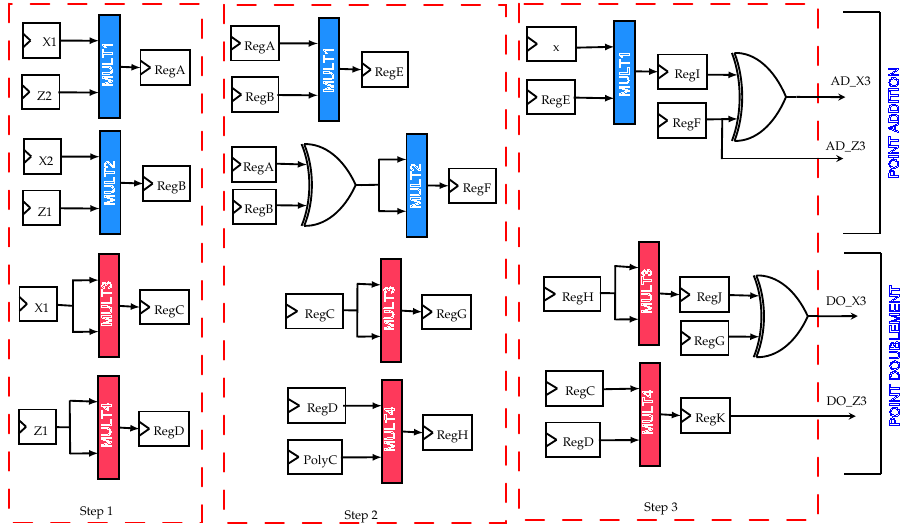
Figure 3. Parallelism between the point addition and the point